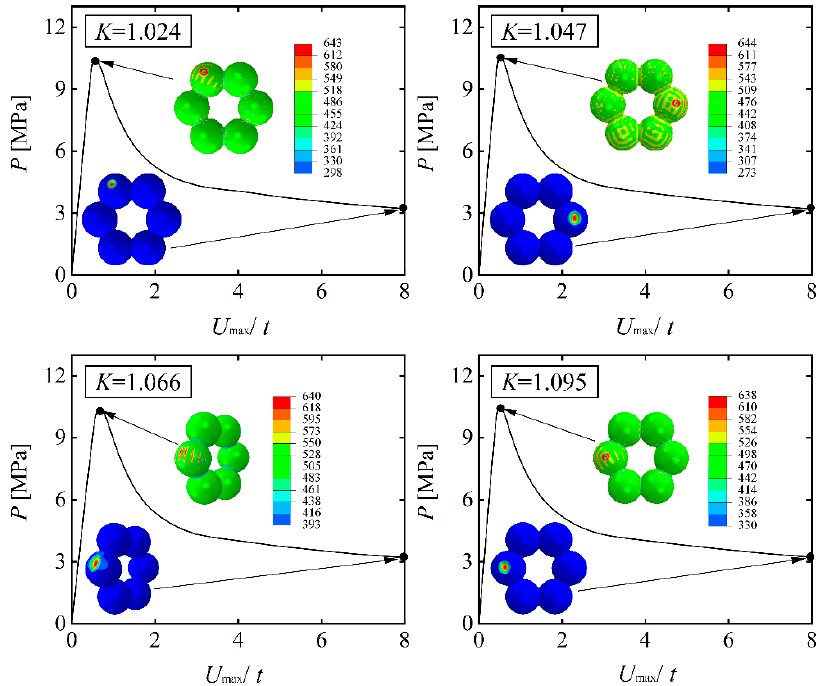
Figure 15. Equilibrium paths of sphere-segmented toroidal shells with ellipticity of ( K ) = 1.024, 1.066, 1.083, and 1.095.